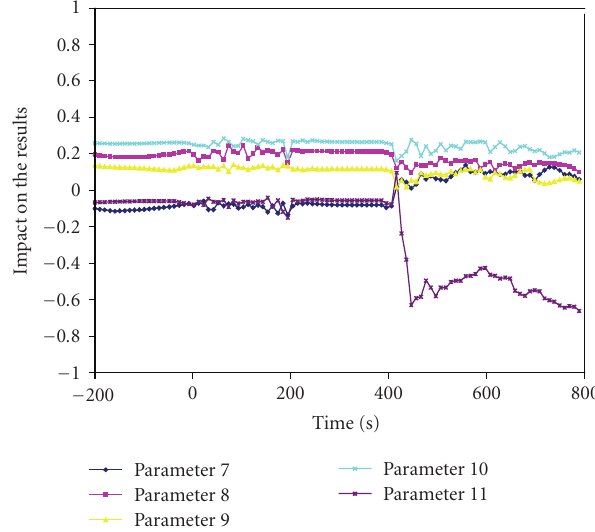
Figure 17: Three MCPs sequential trip. The impact of parameters No.7–No.11 on the coolant flow rate through the a ff ected MCC loop. The numbering of parameters is the same as in Table